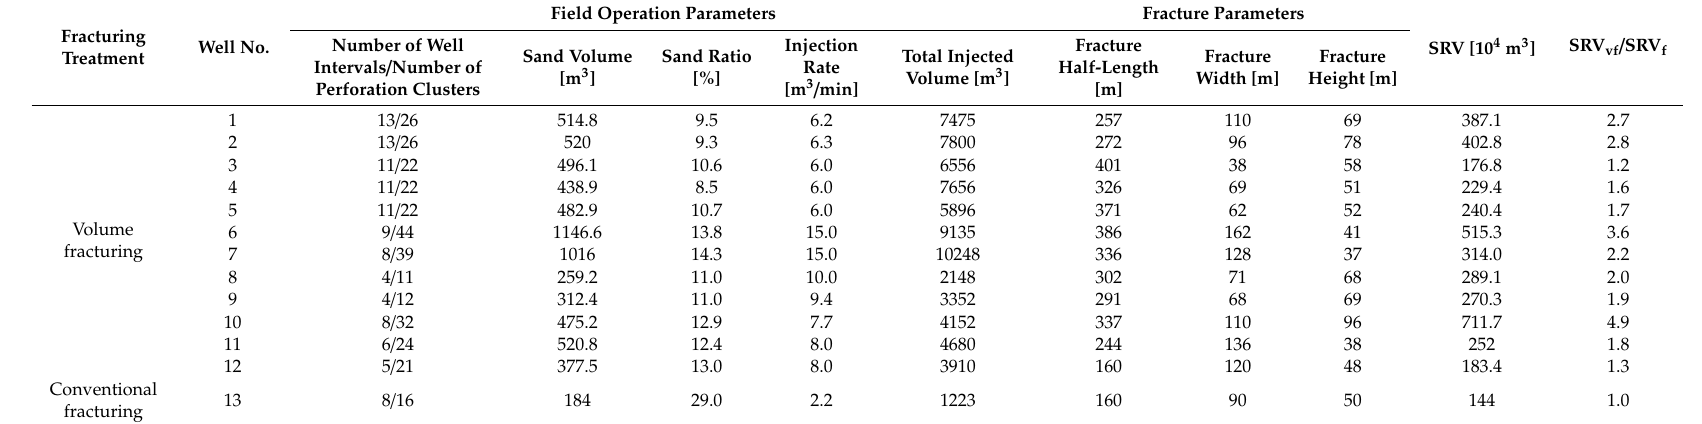
Table 4. Reservoir stimulation results of volume fracturing treatments in Chang